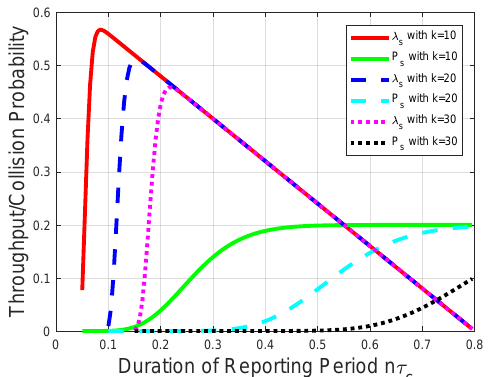
Figure 3. Throughput and collision performances of the CRN with a given sensing